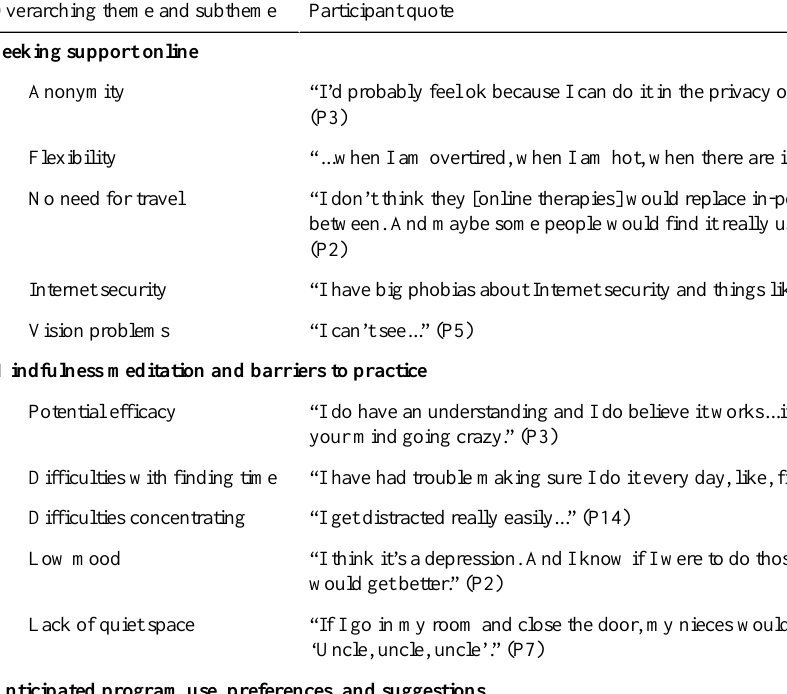
Participant quoteOverarching theme and